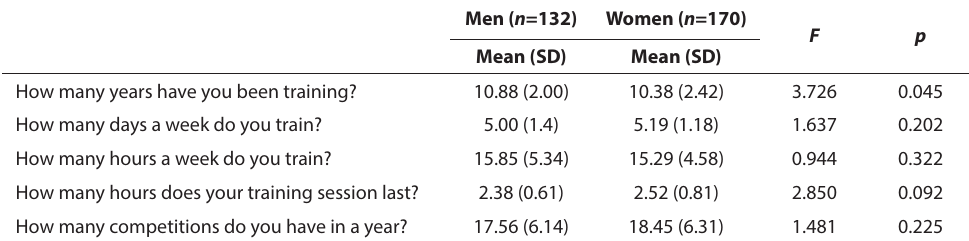
TABLE 1 Means and standard deviations of responses to training volume questions, and one-way ANOVA as a function of sex.